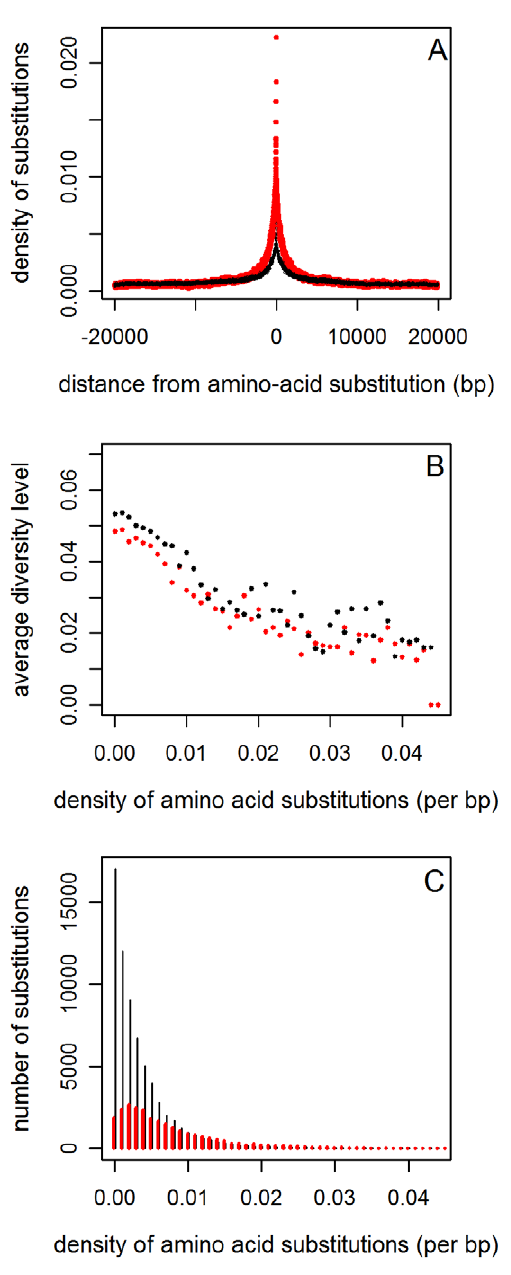
Figure 2. The reduction in diversity around amino acid substitutions, controlling for clustering. A. The density of amino acid (red) and synonymous (black) substitutions as a function of distance from an amino acid substitution. The synonymous density was multiplied by 0.4 (the ratio of the average amino acid to the average synonymous densities) in order to make the comparison of densities more transparent. B. A comparison between the average diversity levels around amino acid (red) and synonymous substitutions (black) as a function of the density of amino acid substitutions in their vicinity. Diversity levels and density of amino acid substitutions were measured in a window size of 1kb centered at the substitution under consideration. C. The numbers of amino acid (red) and synonymous substitutions (black) used to estimate the average diversity levels at each density.